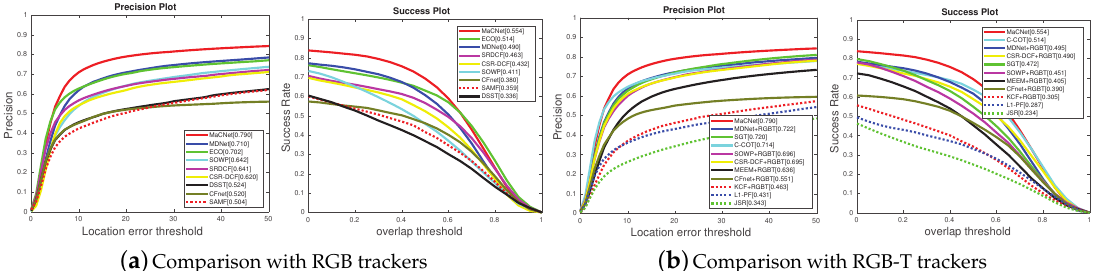
Figure 4. Evaluation results on the RGBT234 [13] benchmark. The representative scores of PR/SR are given in the legend. For a clear comparison, we separately plot the RGB and RGB-T trackers results curves in ( a ) and ( b ).